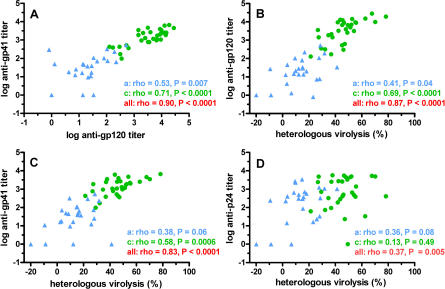
Correlation Analysis of Antibody Responses and Virolysis Activity(A) Correlation analysis of anti-gp120 and anti-gp41 antibody titers in plasma samples from the acute and chronic patient groups shows that titers to the envelope glycoprotein correlate tightly independently of disease stage.(B–D) Correlation analyses of heterologous lysis (JR-FL) with anti-gp120 (B) or anti-gp41 (C) revealed positive correlations, whereas anti-p24 (D) antibody titers did not associate with heterologous lysis. This suggests that lysis activity is driven by envelope-specific antibodies.Blue triangles denote acutely, green circles denote chronically infected patients. Spearman's rank correlation coefficient (rho) and p-values are depicted for the entire cohort (all), the acute patients (a), and the chronic patients (c). If antibody titers were below 1, the value 1 was used for statistical analysis.